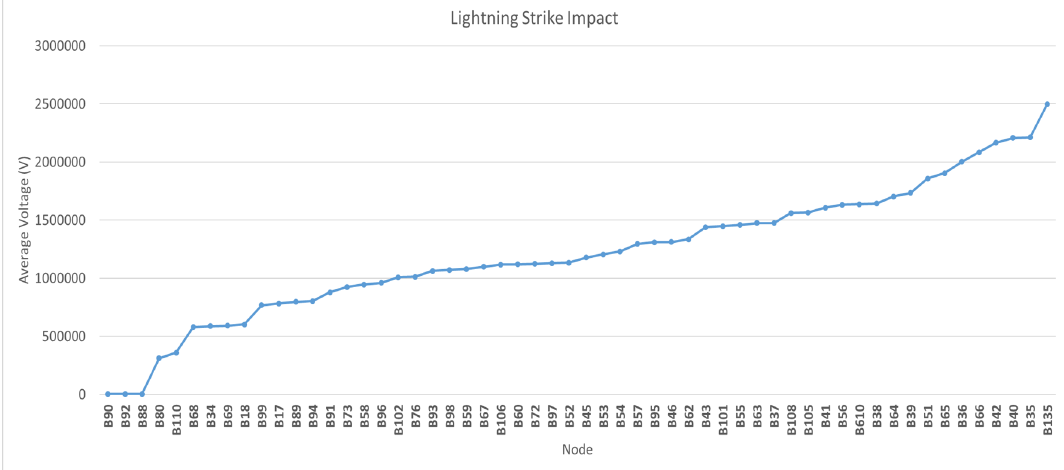
Figure 10. Graphical representation of CMT results for lightning discharges of 10 kA in each electric node of IEEE-123 bus test